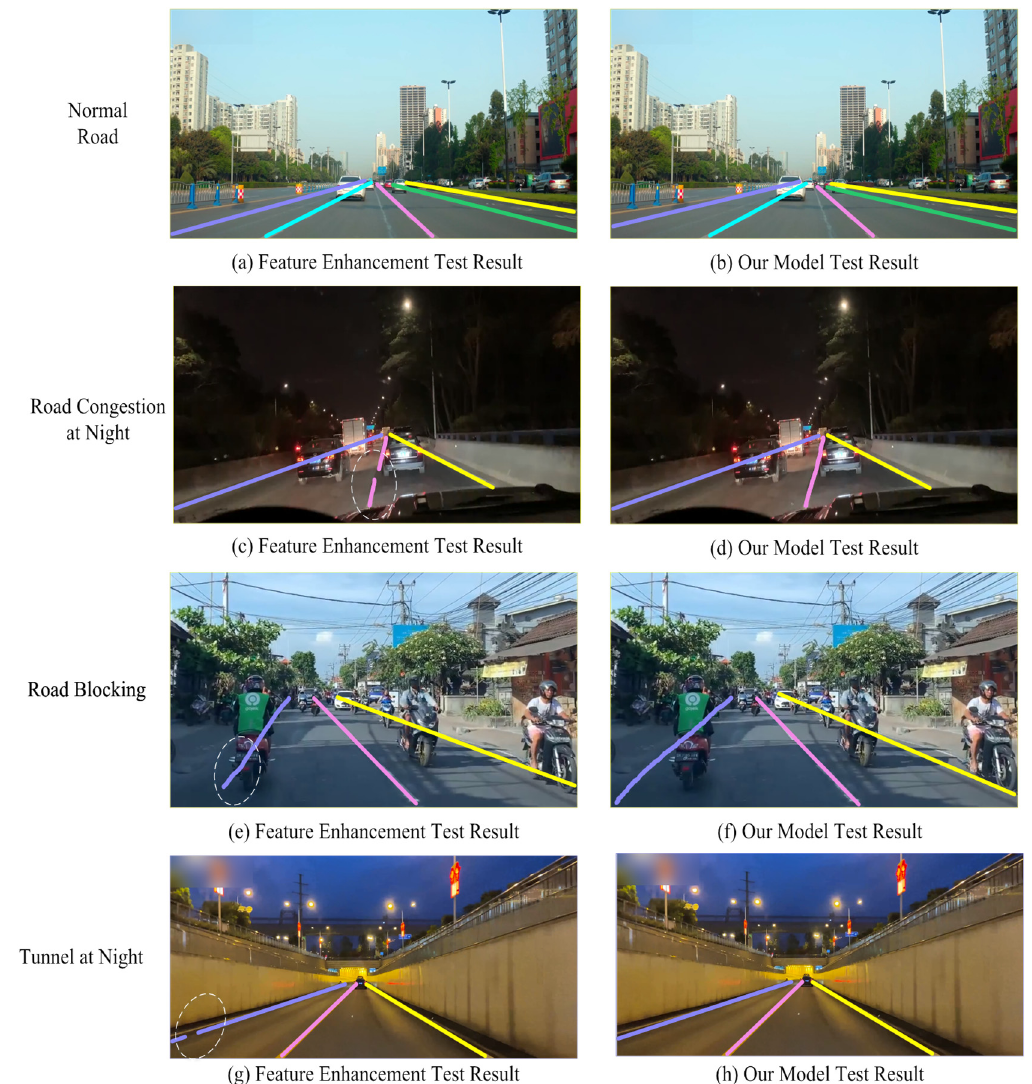
Figure 18. Lane line detection effect in different scenarios.